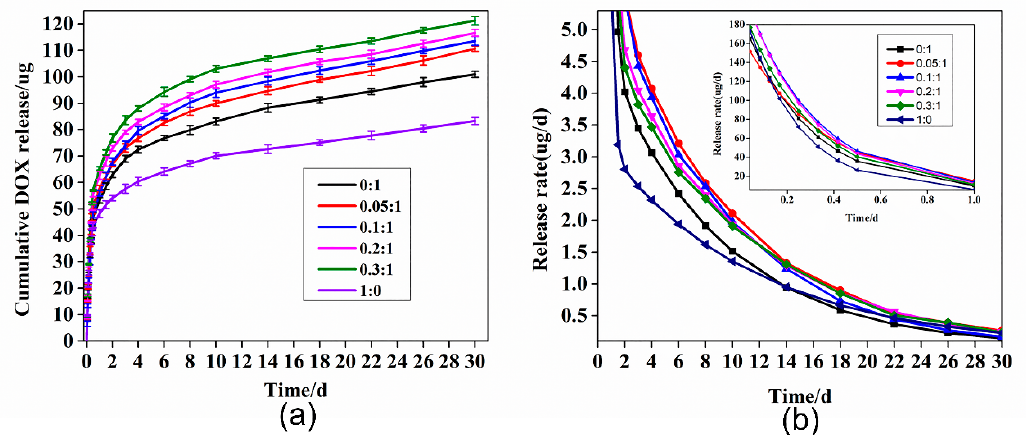
Figure 12. Release profiles of DOX from DOX-loaded nanocomposites prepared from the different addition amounts of c-MWCNTs (tube diameter 30~50 nm, length 0.5~2 μ m) in the MPEG-PDLLA/c-MWCNT mixed solutions: ( a ) cumulative DOX release from drug-loaded micelles and ( b ) the DOX release rate. Data are shown as means ± S.D. ( n =